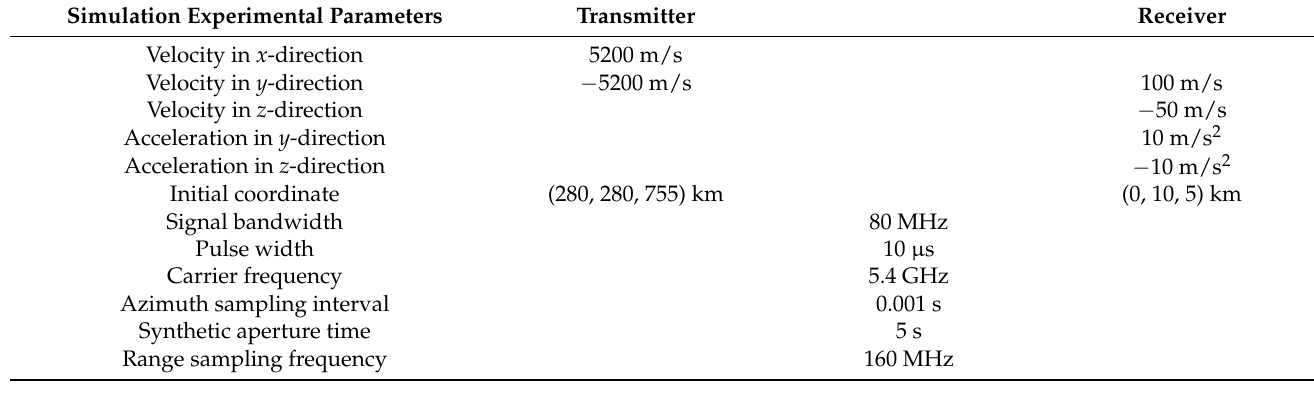
Table 1. Simulation experimental parameters of spaceborne missile bistatic SAR.